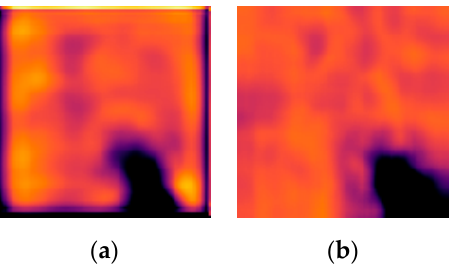
Figure4. Comparisonbetweenadecoderactivationmapwithzero-padding( a )andreflectionpadding( b ). Figure 4. Comparison between a decoder activation map with zero ‐ padding ( a ) and reflection Reflection padding reduces artefacts at the edge of the activation padding ( b ). Reflection padding reduces artefacts at the edge of the activation map.